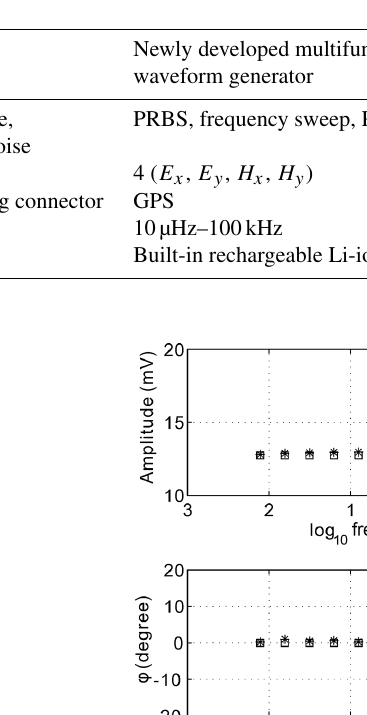
Table 2. Specification comparison with Agilent 33510B.